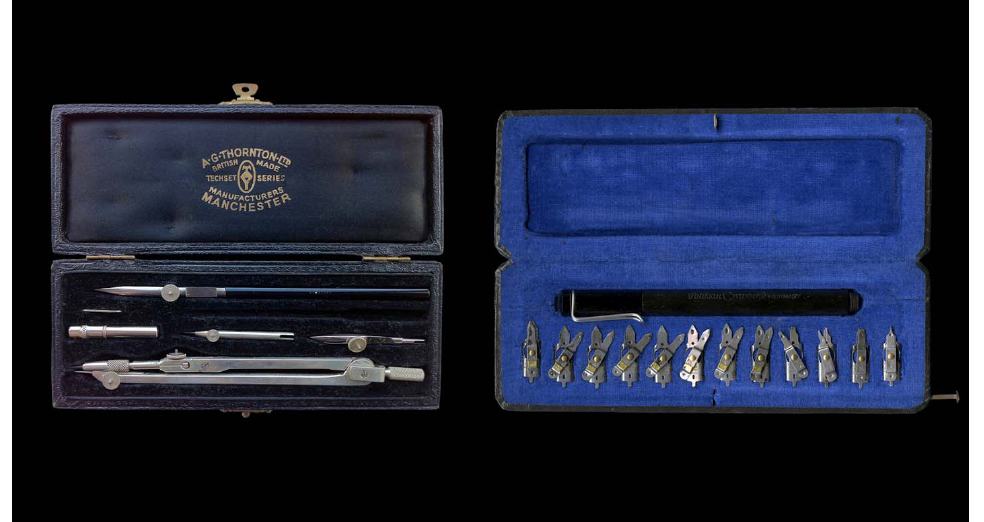
Figure 17. Techset belonging to George McHugh, Engineer, Graphos set belonging to Marco Zambelli, Architect